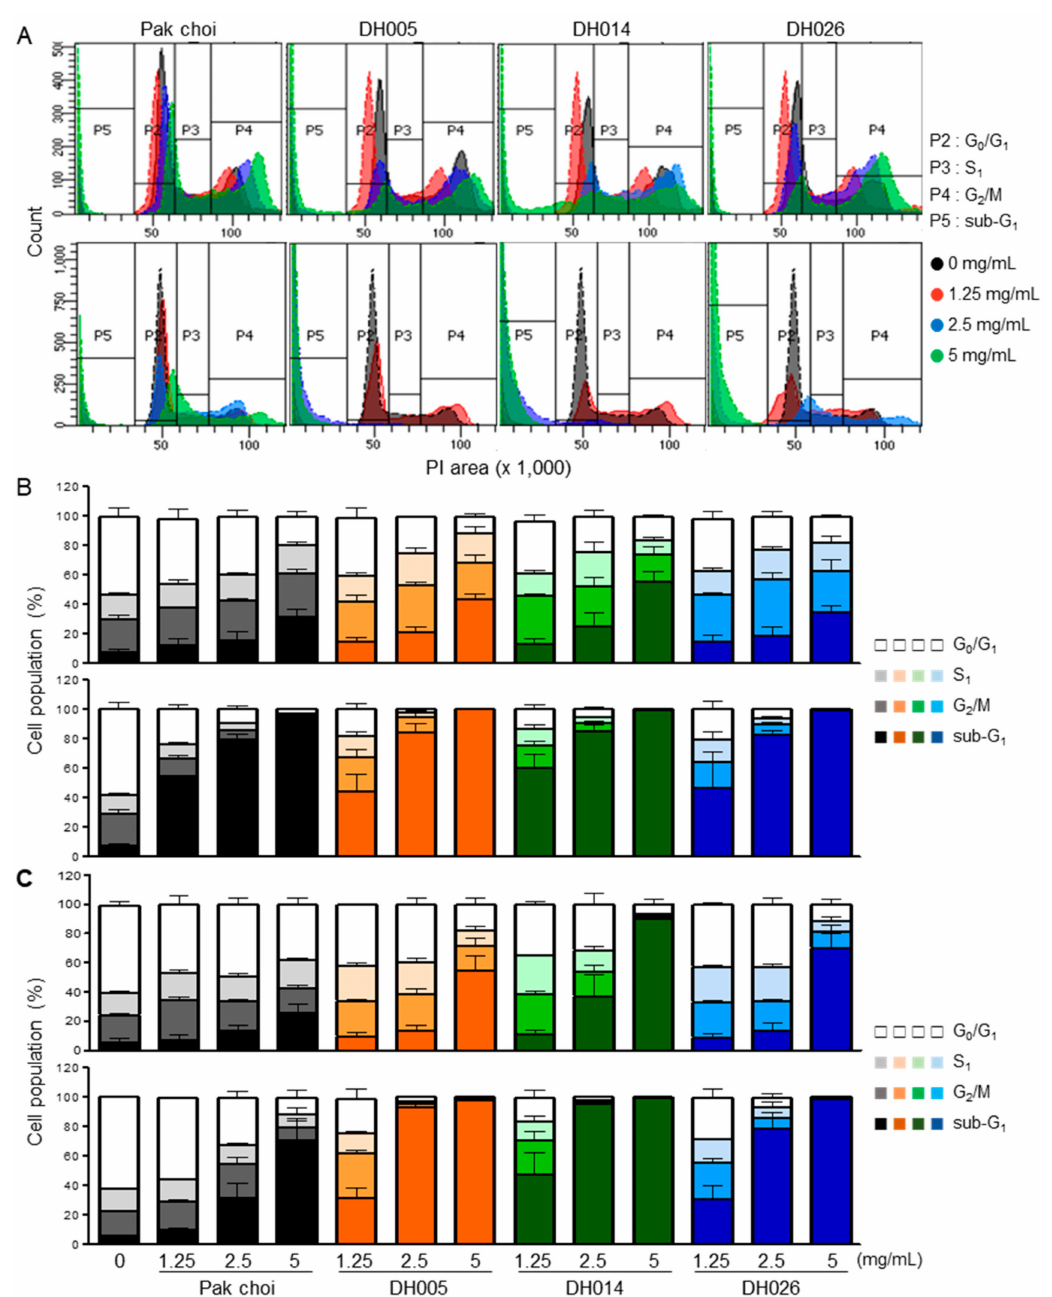
Figure 3. Effects of high glucosinolate (GSL) (HGSL) doubled haploid (DH) lines (DHLs) (DH005, DH014, and DH026) on the cell cycle in human colorectal cancer (CRC) cells. HCT116 and SW480 cells were treated with each HGSL DHL extract or pak choi extract as a control for 24 or 48 h. The treated cells were stained with propidium iodide (PI), and the staining was analyzed using flow cytometry. Every PI staining and analysis was performed at least three times in duplicate. ( A ) The representative analysis of the 24 h-treated cells (upper: HCT116 and lower: SW480) was shown in the histograms. The population of HCT116 ( B ) and SW480 ( C ) cells were quantitated as a percentage of cell numbers in the G 0 /G 1 , S, G 2 /M, and sub-G 1 phases. Data (upper: 24 h and lower: 48 h) represent the mean ±